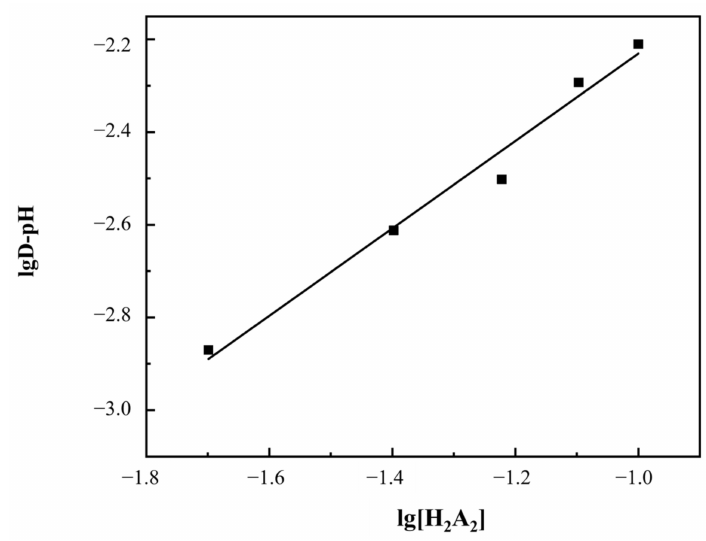
Figure 9. The relationship between the lg D of Y 3+ and lg [H 2 A 2 ]. The anions in the aqueous phase have an influence on the extraction process to some extent. When REEs are in contact with anions such as chloride, nitrate, and sulfate, they complex with these anions to form various forms of species [45,46]. For example, with chloride, they present in the solution as REE 3+ , REECl 2+ , REECl 2+ , REECl 3 , and REECl 4 − (where REE stands for trivalent rare earth elements). In this study, only REE 3+ is considered in the analysis, just to show the interaction between REEs and the solvent in the organic phase. Setting the experimental conditions as Y 3+ 0.01 M and extractant concentration as 0.3 M, the effect of Cl − concentration on the distribution ratio of Y 3+ extracted was investigated, and the relationship between lg D and lg [Cl − ] was established. It can be seen from Figure 10 that the slope is about 2. Every Y 3+ is extracted, and there will be two Cl − involved in the reaction. Therefore, it can be determined that n in the Equation (3) is equal to 2.